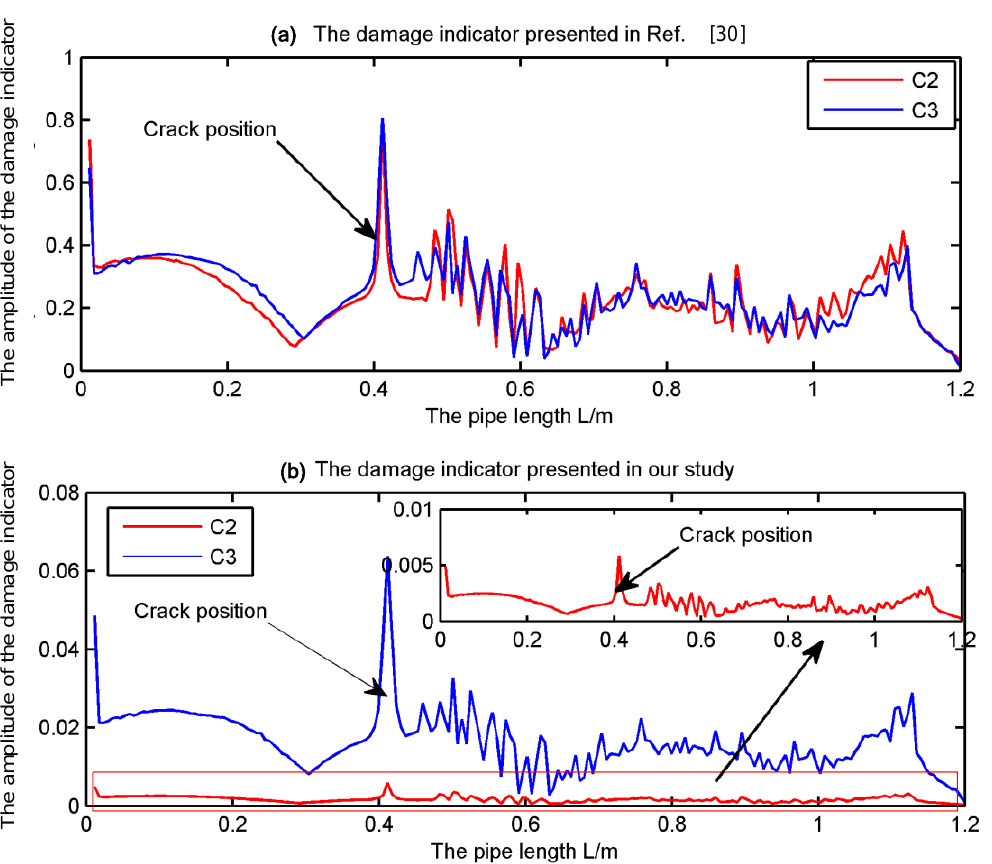
Figure 7. The comparison of the damage indicators presented in Reference [30] and our present study.